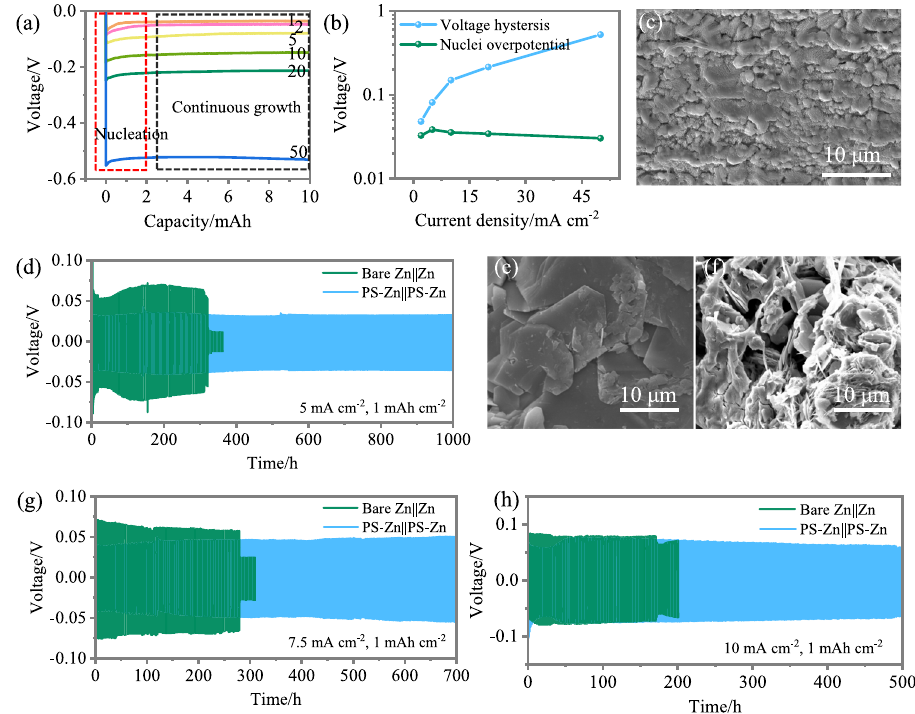
Fig. 5 Electrochemical and microscopy characterizations of Zn metal electrodes. a Voltage pro fi le of Zn deposition under various current densities (mA cm − 2 ); b voltage hysteresis and nuclei overpotential vs. current density; c ex situ SEM micrograph of the P-Zn electrode cycled at 50 mA cm − 2 ; d voltage – time pro fi les of bare Zn||Zn and PD-Zn||PD-Zn symmetric cells at current densities of 5 mA cm − 2 , 7.5 mA cm − 2 , and 10 mA cm − 2 ; e morphology of PD-Zn electrode after 1000h cycling at 5 mA cm − 2 ; f morphology of bare Zn within the short-circuited cell after 360 h cycling at 5 mA cm − 2 ; voltage – time pro fi les of bare Zn||Zn and PD-Zn||PD-Zn symmetric cells at current densities of g 7.5 mA cm − 2 and h 10 mA cm − 2